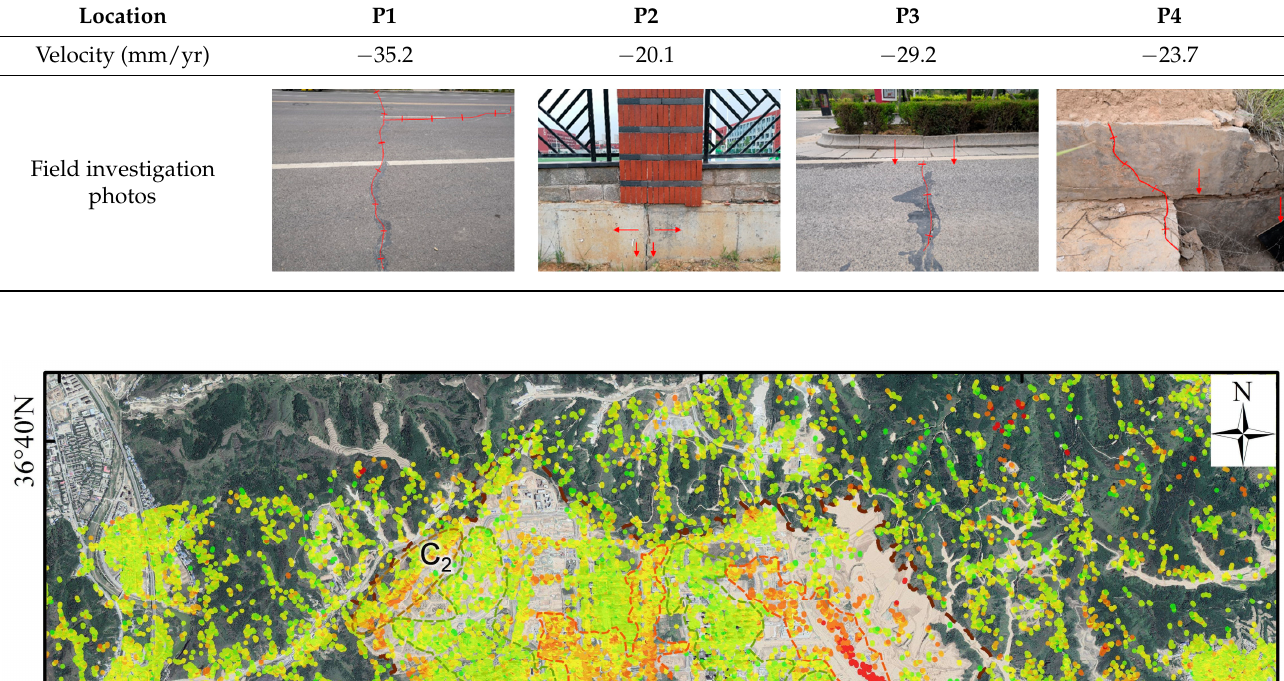
Figure 6. Annual deformation rates in the Yan’an New District. The dashed line outlines the main deformation area. The black triangles correspond to the four typical sample areas used in the field surveys and the time series analysis (see Table 3 and Figure 7). Table 3. Examples of the ground deformation characteristics obtained from the field survey.